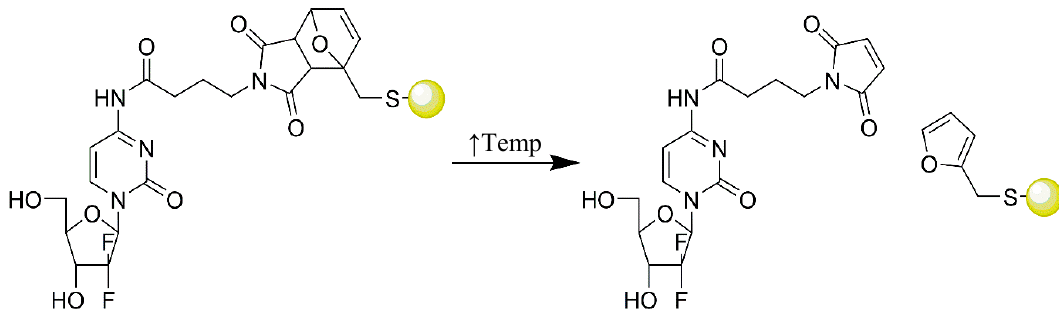
Figure 7. Schematic representation of hybrid nanoparticle with gemcitabine coupled onto its surface via a Diels Alder cycloadduct and its subsequent retro Diels Alder reaction after heating, liberating free gemcitabine.